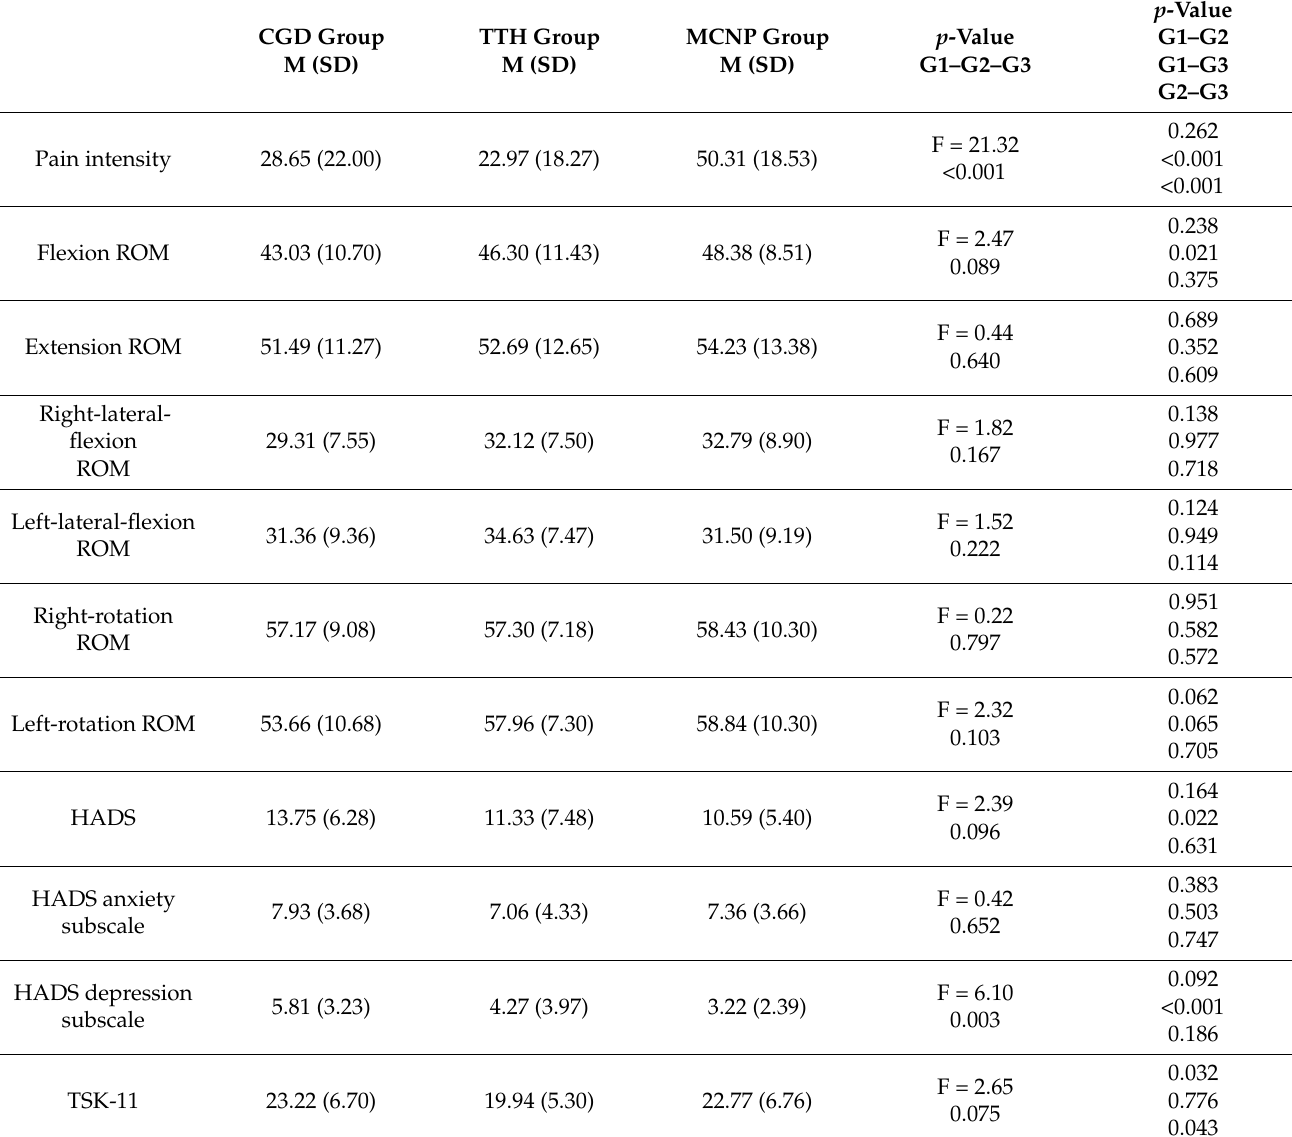
Table 2. Outcome-variable comparison between the three